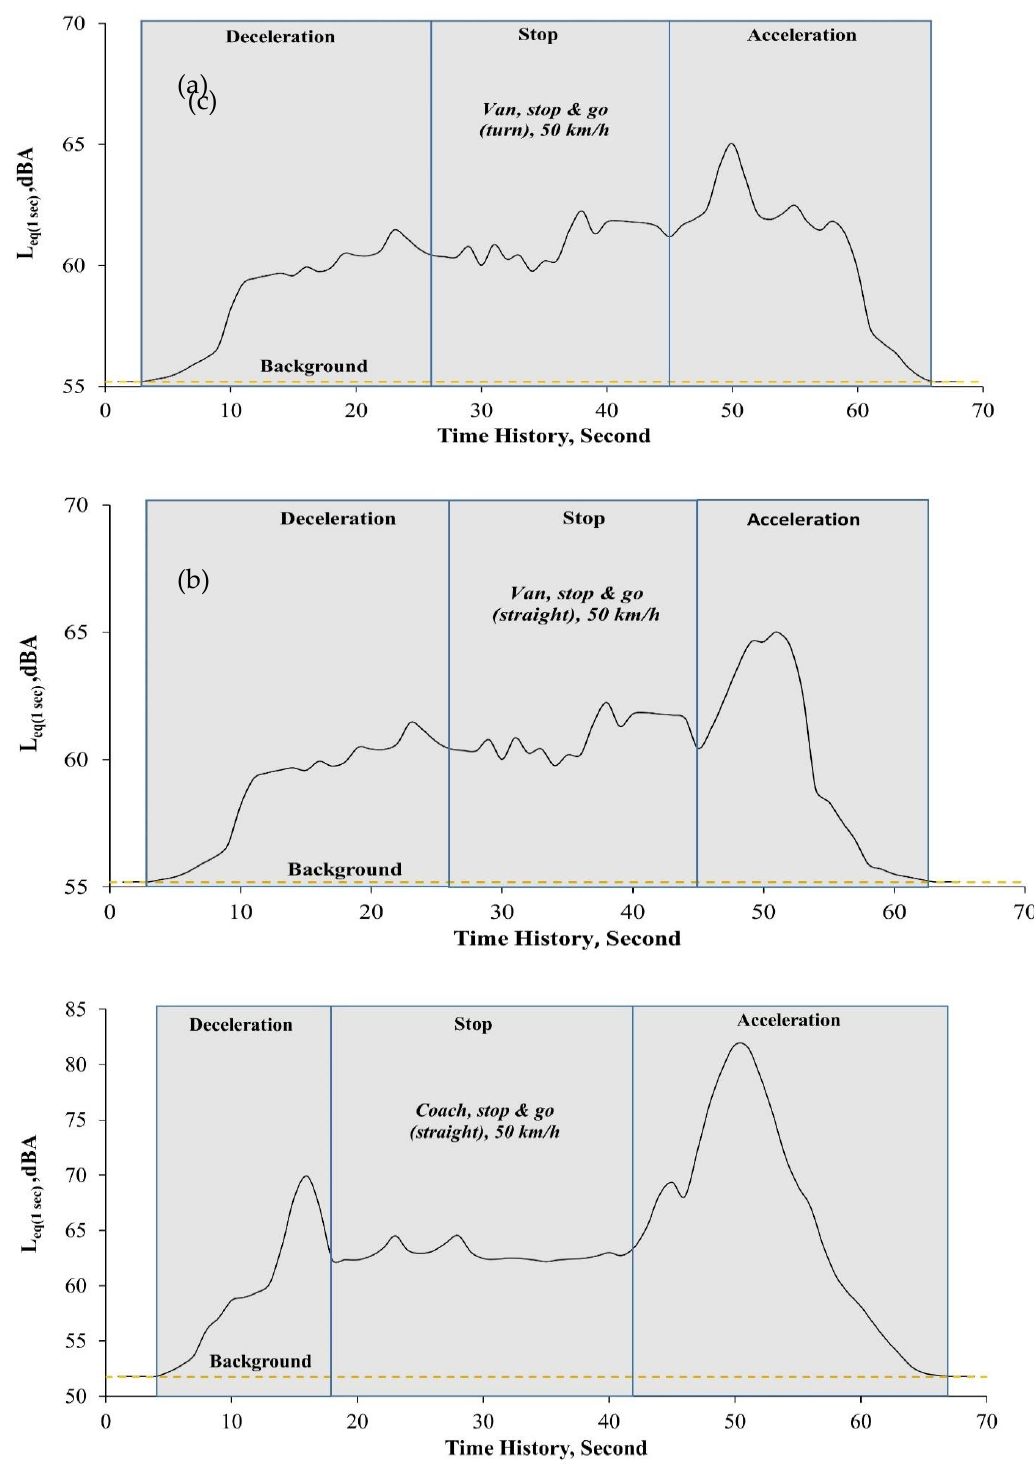
Figure 6. A comparison of average sound pressure levels under “stop and go” traffic scenarios. ( a ) Van, turn; ( b ) Van, straight; ( c ) Coach, straight.